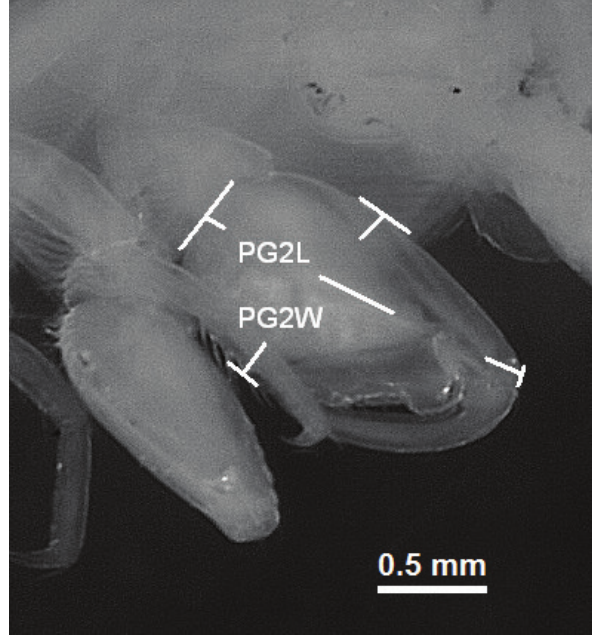
Figure 3. Length (PG2L) and width (PG2W) of the propodus of the second gnathopods in Quadrivisio lutzi